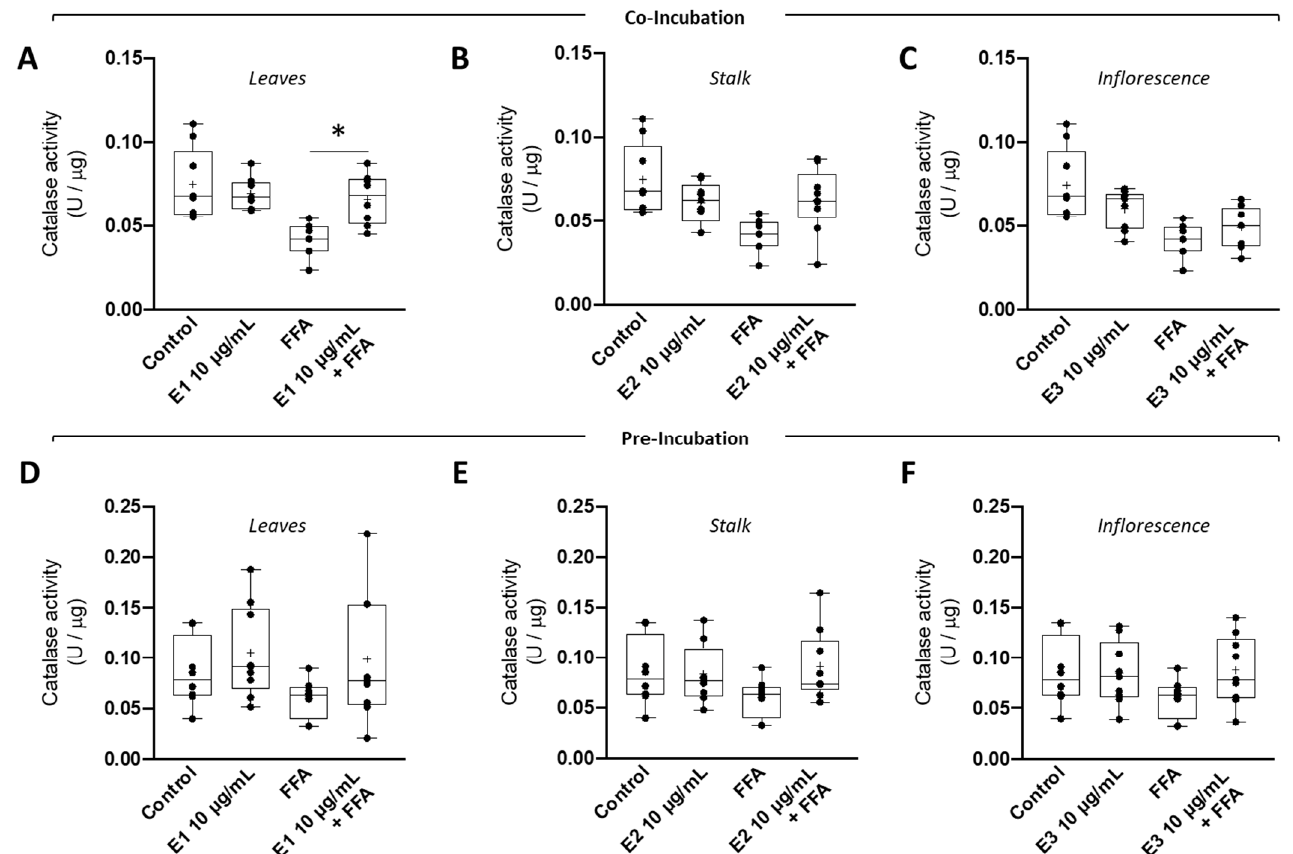
Figure 5. Effect of broccoli extracts on the activity of antioxidant enzyme catalase under supra-physiological concentrations of fatty acids (FA) in human HepG2 cells . HepG2 cells were ( A – C ) co-incubated or ( D – F ) pre-incubated with BBP extracts (( A , D ) leaves—E1, ( B ) and ( E ) stalks—E2, or ( C , F ) inflorescences—E3) and then subjected to supraphysiological concentrations of free fatty acids. Catalase activity was assessed in HepG2 cells through the capacity to decompose H 2 O 2 . Data are the mean ± SEM of four different assays performed, and the results were normalized on the control condition (CTL = 100%). The data obtained with BBP extracts were compared to CTL using a one-way ANOVA with Dunnett’s multiple comparison post-test. Significant differences between the indicated conditions are marked by * ( p <